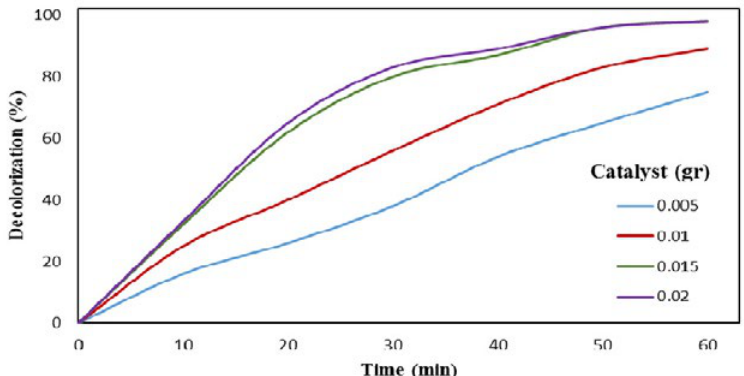
Fig. 3. Effect of visible light irradiation on the decolorization efficiency (%). Reaction conditions: MG=20 mg/L, catalyst=0.015g, p H=natural and room temperature.